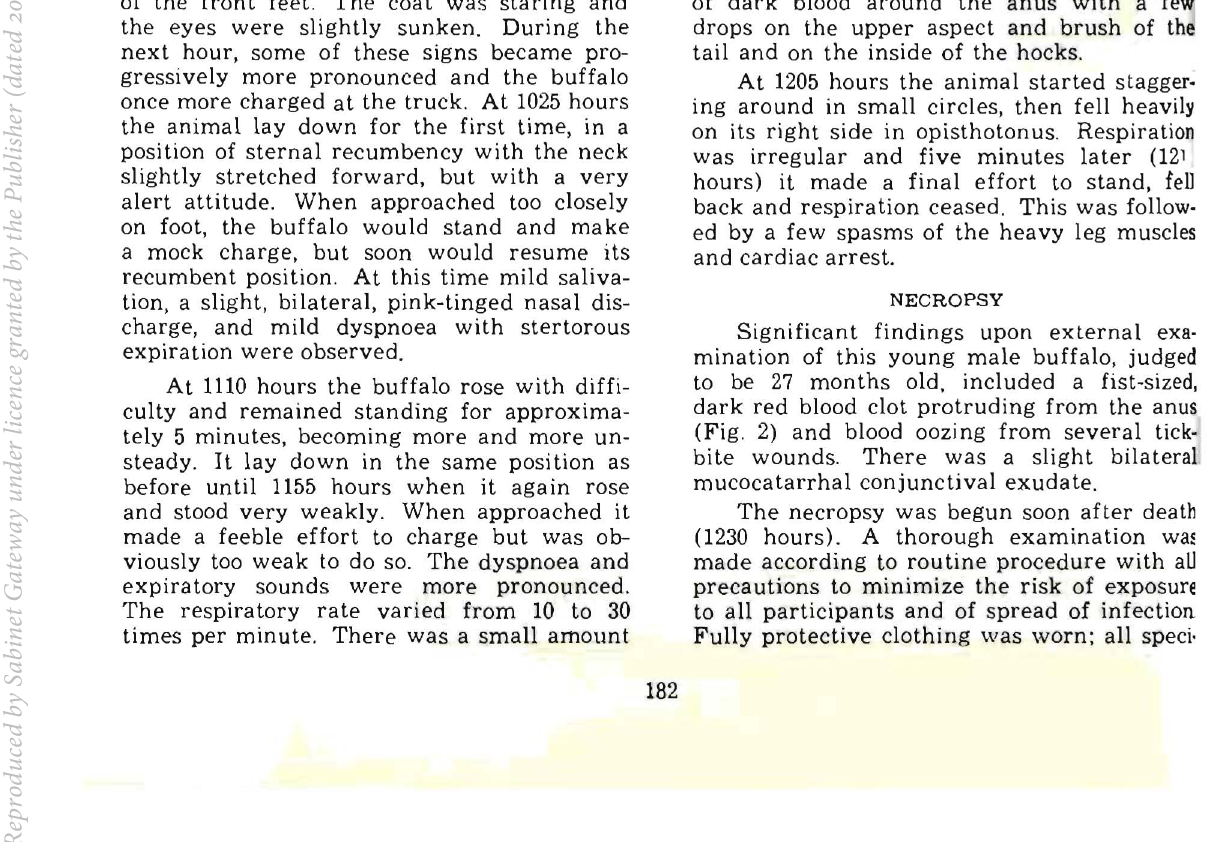
FIG.!. Adult male Afrlcan buffalo showing alert attitude. approximately 3 hours before death. FIG. 2. Large blood clot which was expelled from the anus just after death. FIG. 3. Various lymph nodes showing the marked difference between tho~e draining the digestive tract (pharyQ geal, mesenteric and gastric) compared to the peripheral ones (superficial cervical, iliac and subiliac). FIG. 4. Marked splenomegaly. Note the haemorrhages on the omasum and mesenteric oedema' in the backgroun~ FIG. 5. Blood tinged hydropericardium and epicardial haemorrhages. Note the dark black appearance of the blood (lower right corner). FIG. 6. Olive-brown necrotic pharyngitis. View from under the mandible with tongue and larynx removed.